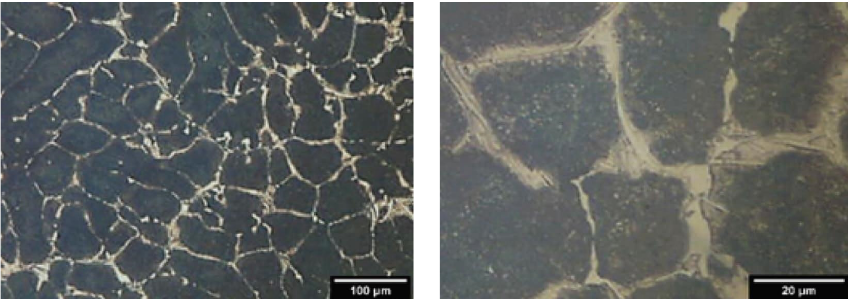
Figure 5: Microstructure of 3V-8W steel in the as-cast condition.